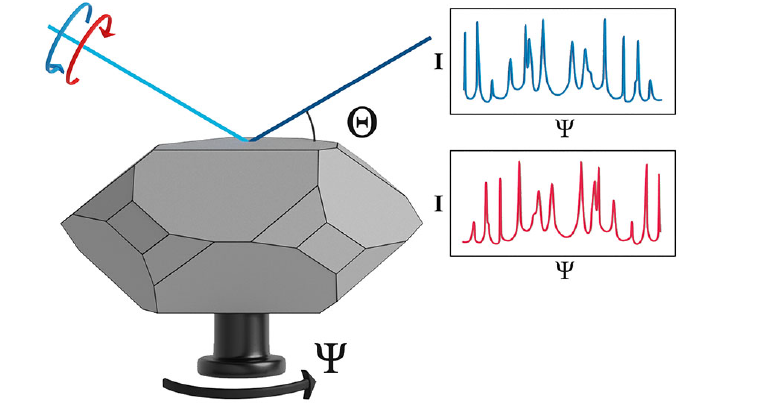
Figure 2. Schematic diagram of experiment. A circularly polarized X-ray radiation with an incident wave vector corresponding to the forbidden reflection falls on the crystal. The crystal rotates around the azimuthal axis by an angle of Ψ . The intensity curves look mirror-like for the left (blue curve) and right (red curve) polarizations of the incident beam.